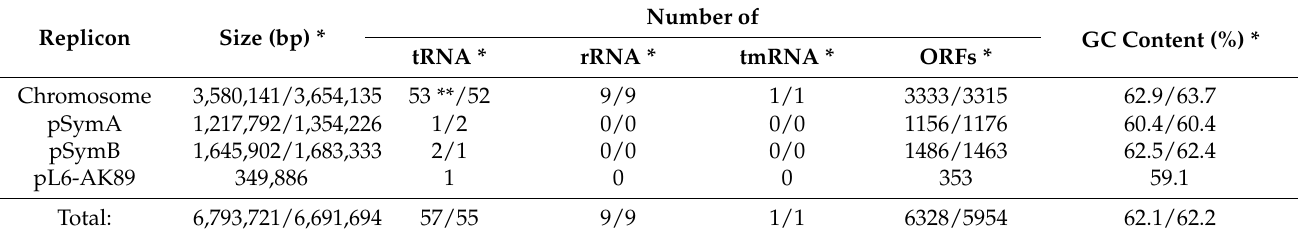
Table 2. Characteristics of replicons of L6-A К 89 compared to reference strain